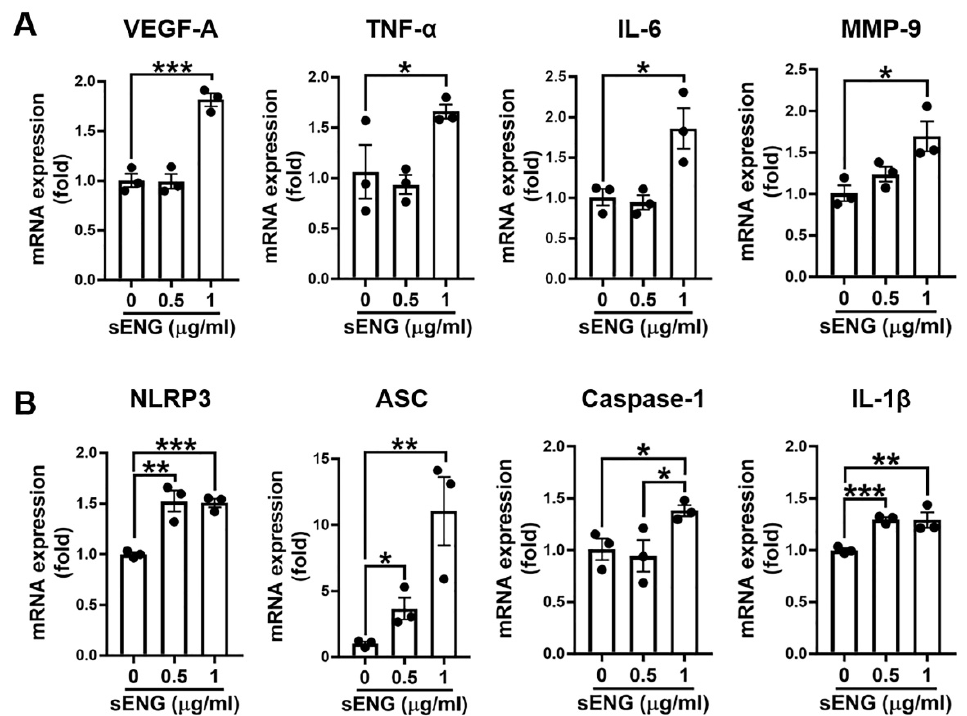
Figure 3. Soluble ENG induced gene expression of angiogenic and inflammatory mediators in microglia. ( A , B ) Change of gene expression levels of angiogenic mediator and inflammatory cytokines ( A ) and inflammasome markers ( B ) in BV2 microglia by sENG treatment. BV2 cells were stimulated with 0.5 or 1 μ g/mL of sENG for 24 h. Each mRNA level was normalized with GAPDH. n = 3; data are presented as mean ± SEM; * p < 0.05, ** p < 0.01, *** p < 0.001; Student’s t- test.